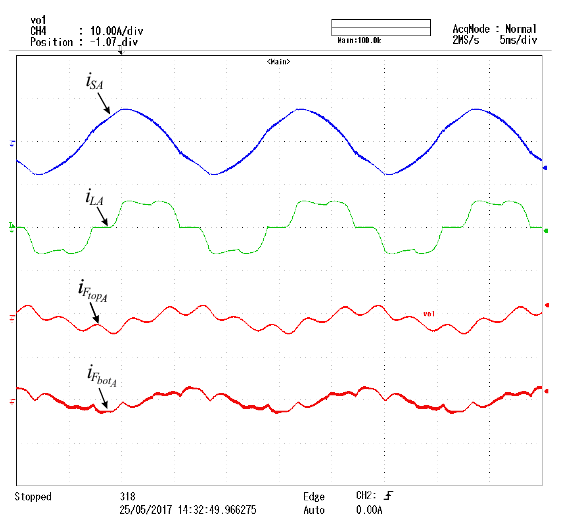
Figure 15. Current waveforms for Phase A. From top to bottom: grid ( i SA ), load ( i LA ), top unit ( i F and bottom unit ( i F botA